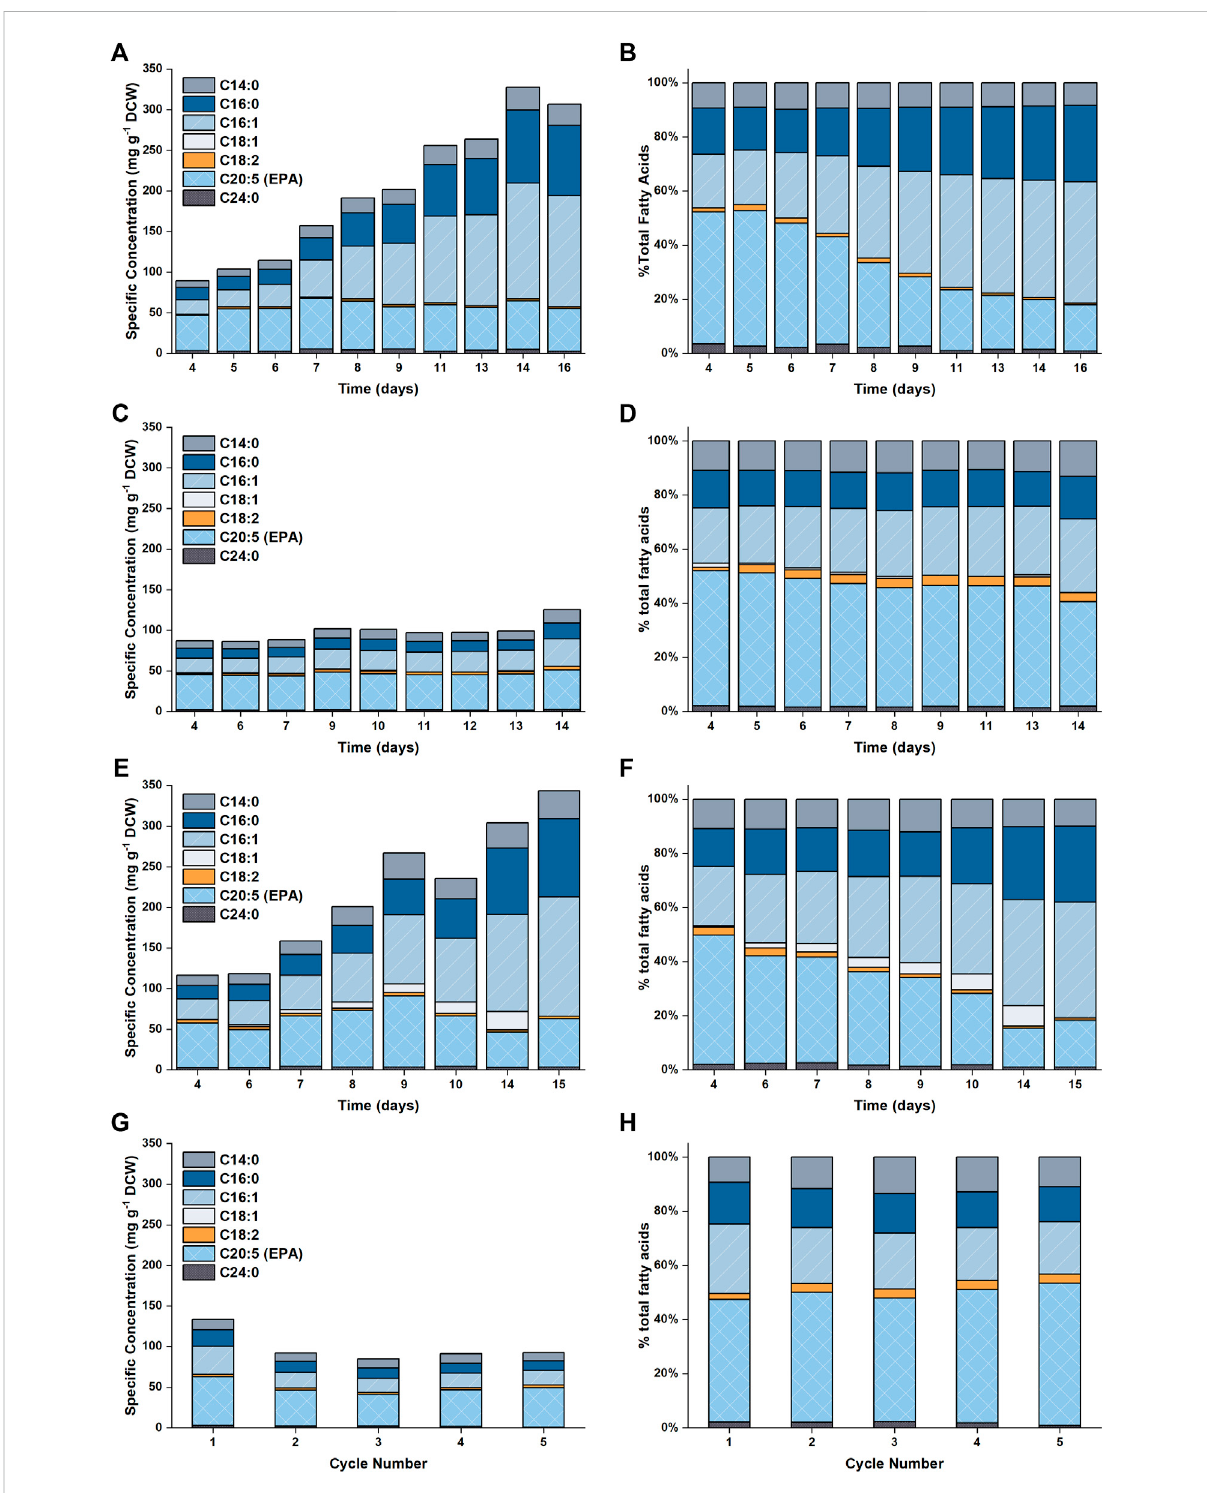
FIGURE 5 Plot showing the fatty acid pro fi les as a function of time for the different experimental conditions examined in this work. Results are shown in (A,B) for 5 L cultures (C,D) for 50 L cultures with N replete medium, (E,F) for 50 L cultures with N limited medium and (G,H) for the repeated batch